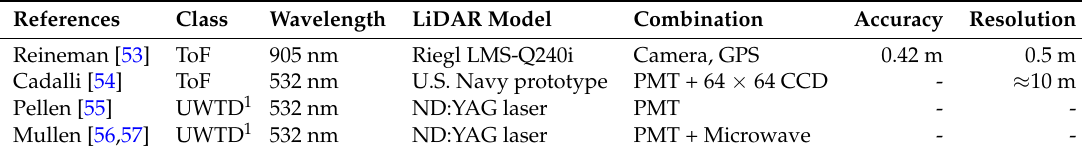
Table 2. Summary of LiDAR 3D reconstruction solutions.